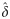
Simulations illustrating the false signal of NDDD in a field study.Parameter estimates generated for 10 different trap displacement choices applied to the Opiro et al. study on G. f. fuscipes in Uganda [11]. A. Dispersal distance (log(δ^)) vs effective population density (log(D^e)). B. Dispersal distance (log(δ^)) vs surface area (log(S^)) occupied by the effective population. C. Regression coefficient (log(b)) vs effective population density (log(D^e)). D. Effective population size (log(N^e)) vs effective population density (log(D^e)). E. Effective population size (log(N^e)) vs surface area (log(S^)) occupied by the effective population. F. Surface area (log(S^)) occupied by the effective population vs effective population density (log(D^e)).